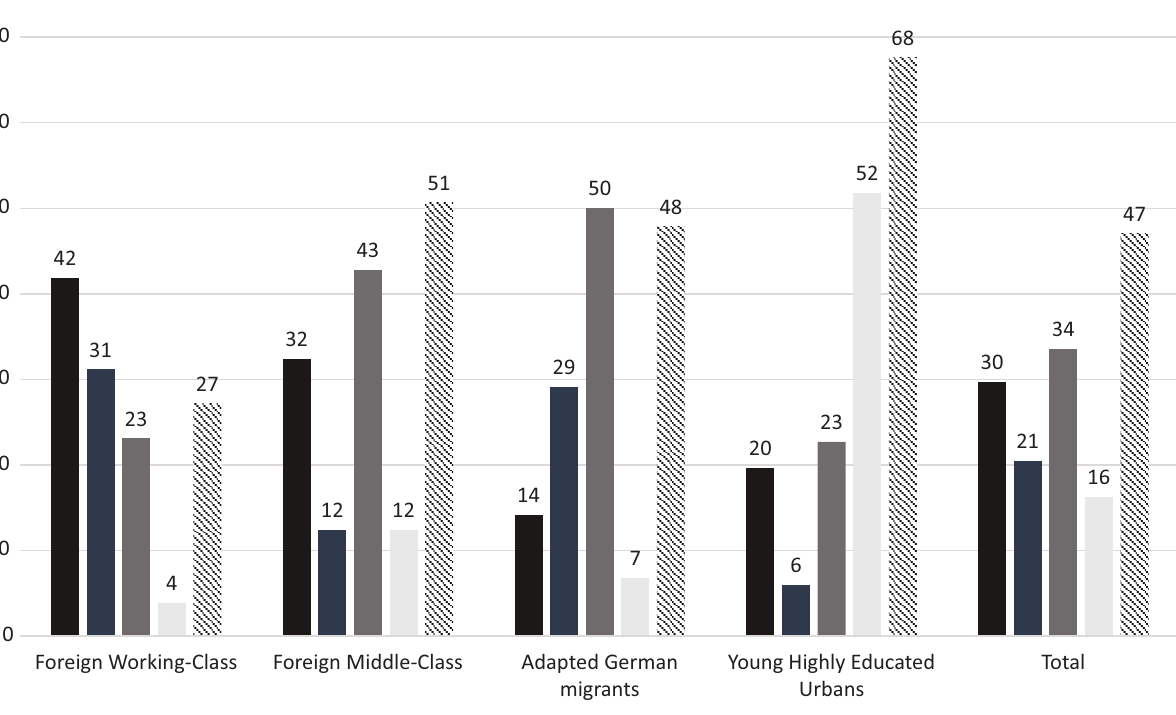
Figure 5. Training required and proportion of those with an occupation corresponding to training. Note: *only respondents with training. Source: SOEP (2019, survey year 2015), weighted